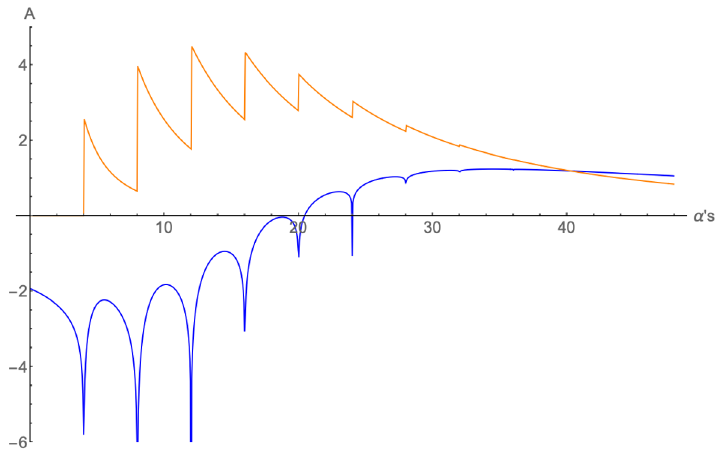
Figure 2 . Top: real (blue line) and imaginary (orange) parts of the amplitude computed in the hard wall model, eq. (4.29), with ∆ = 8 , and cos θ = 0 . 8 . The plot shows a structure of singularities that fade away as we increase the